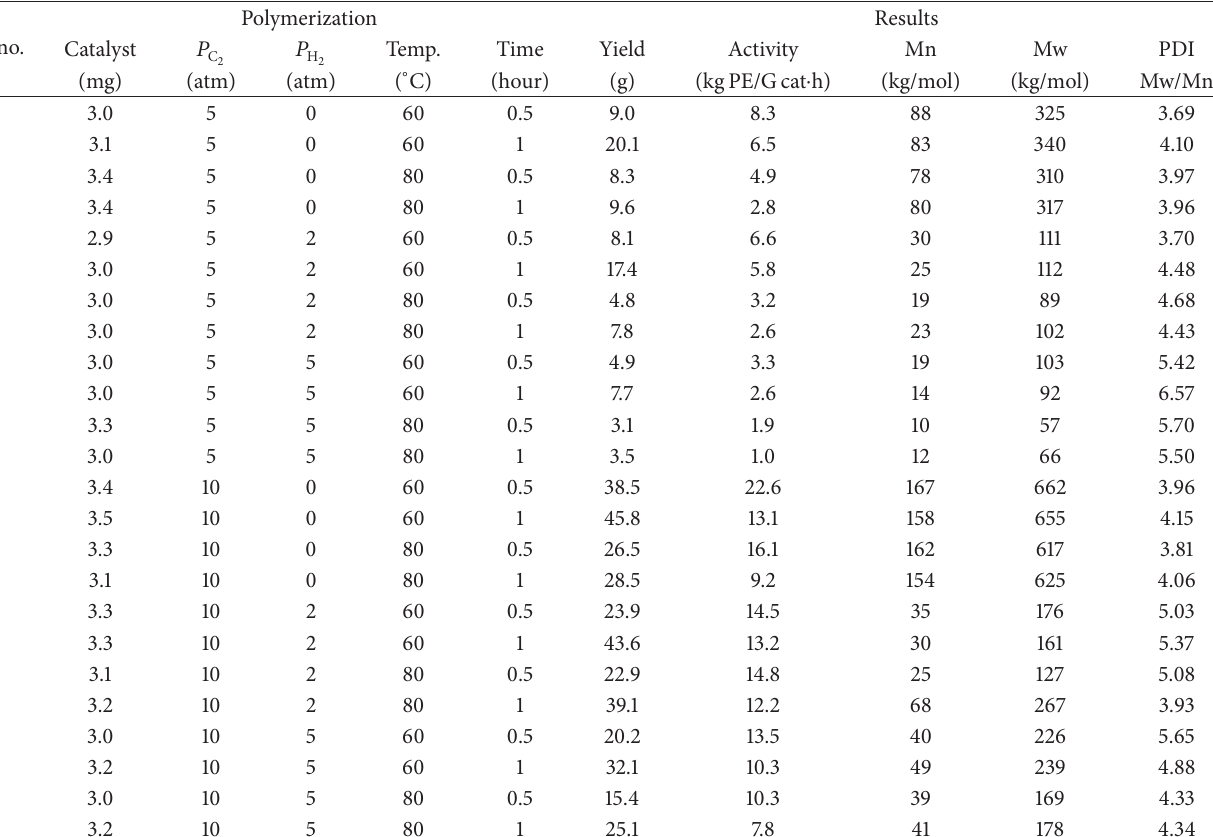
Table 1: Ethylene polymerization using Ziegler-Natta